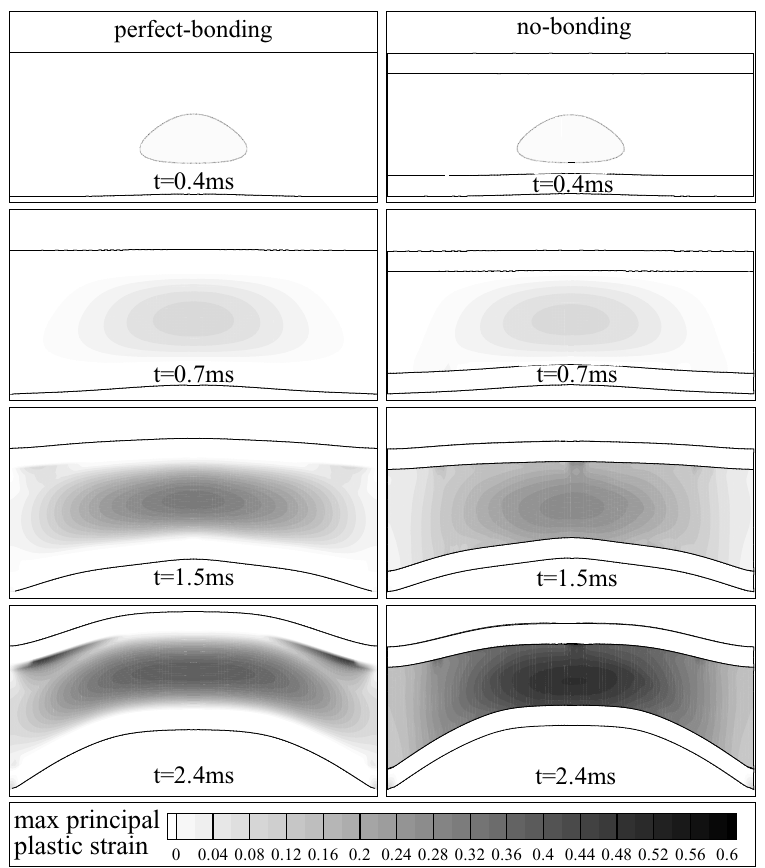
Fig. 15. Comparison of the maximum principal plastic strain contours at different time instances between the perfect- and no-bonding sandwich plates with clamped ends. bottom row of Fig. 17). In addition, the loss of interface bonding significantly altered the horizontal displacement distributions while it had negligible influence on the vertical displacement distributions. This indicates that the loss of interface bonding causes primarily slippage between layers instead of interface delamination during the early stage of UNDEX near sandwich plates (where local buckling is not a